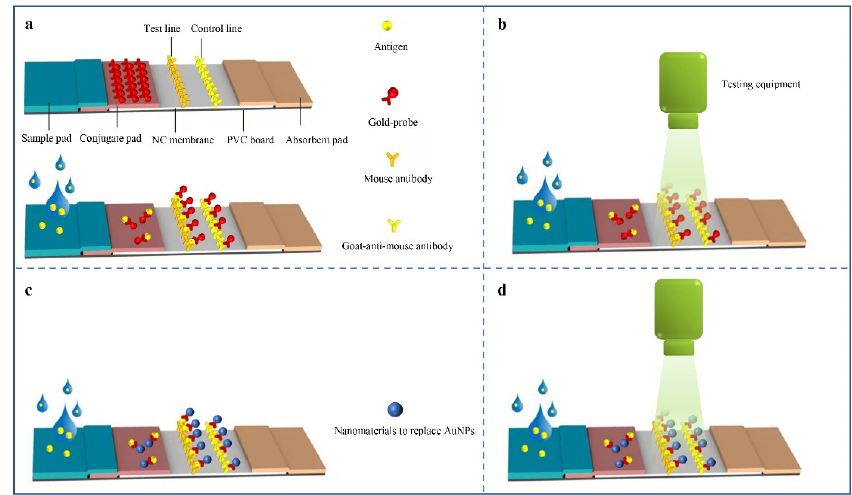
Figure 3. ( a ) Structure and principle of the traditional colloidal gold immunochromatographic strip. Its detection principle is as follows: (1) the markers combine with gold-probes on the conjugate pad, to form complexes after the user drops positive samples; (2) then complexes are captured by the antibodies at the test line and generate a red line; (3) the gold-probes without binding marker are captured by the goat-anti-mouse antibodies at the control line. If the control line is not red, the gold-probes may be invalid. ( b ) Demonstrated a method for achieving sensitivity enhancement through an external detection device. ( c ) Represents a class of methods using other nanomaterials (such as carbon nanoparticles, carbon nanotubes, and gold nanocages) instead of AuNPs, to improve detection sensitivity. ( d ) Shows a combination of the methods shown in ( b , c ).